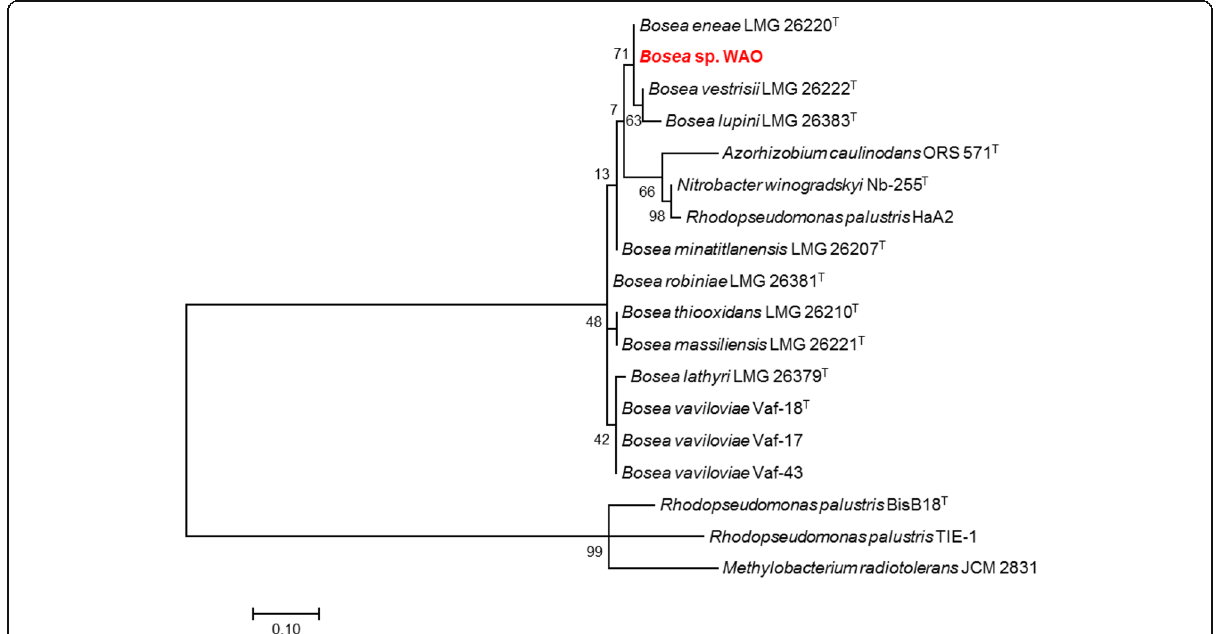
Fig. 7 Molecular Phylogenetic analysis by Maximum Likelihood method of rpoB gene. The evolutionary history was inferred by using the Maximum Likelihood method based on the Tamura-Nei model [19]. The tree with the highest log likelihood ( − 419.8311) is shown. The percentage of trees in which the associated taxa clustered together is shown next to the branches. Initial tree(s) for the heuristic search were obtained automatically by applying Neighbor-Join and BioNJ algorithms to a matrix of pairwise distances estimated using the Maximum Composite Likelihood (MCL) approach, and then selecting the topology with superior log likelihood value. The tree is drawn to scale, with branch lengths measured in the number of substitutions per site. The analysis involved 18 nucleotide sequences. Codon positions included were 1st + 2nd + 3rd + Noncoding. All positions containing gaps and missing data were eliminated. There were a total of 76 positions in the final dataset. Evolutionary analyses were conducted in MEGA7 [20]. Type strains are indicated with a superscript T